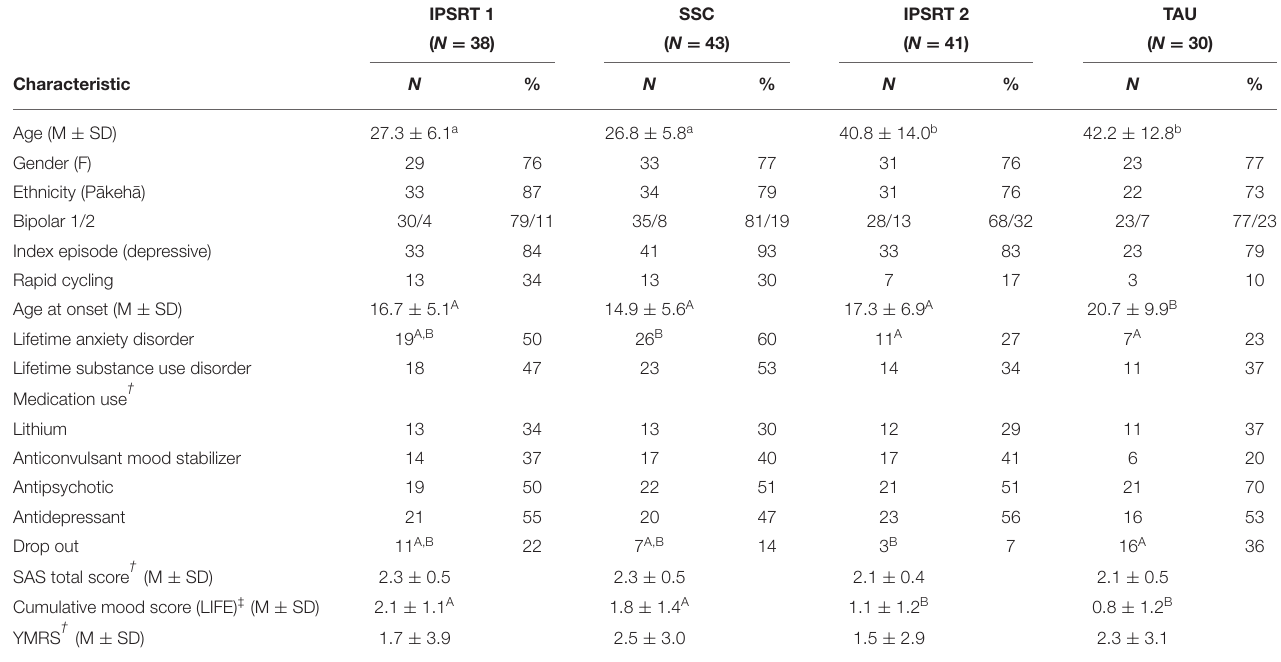
TABLE 1 | Clinical characteristics by treatment